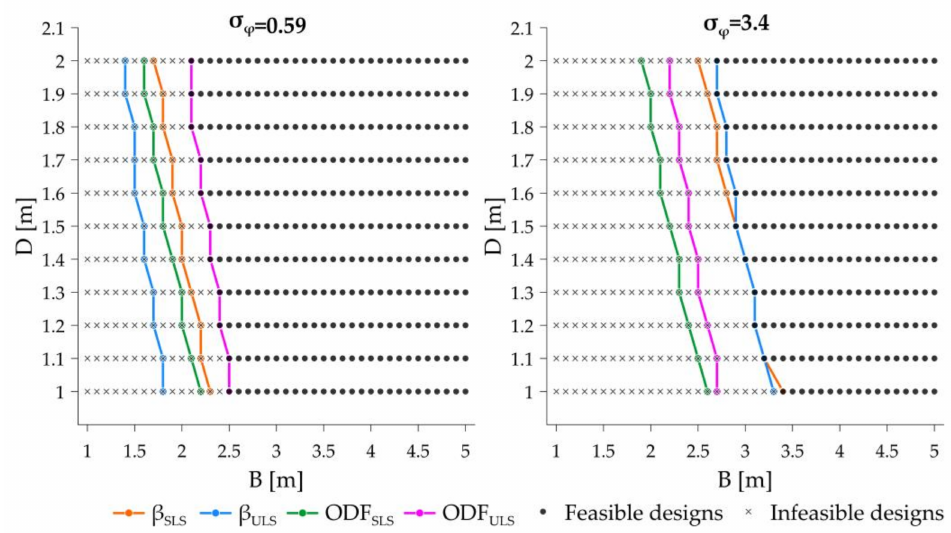
Figure 12. The analysis of constraints on the position of feasible/infeasible design in design space for σ φ = 0.59 ( left ) and for σ φ = 3.4 ( right ).